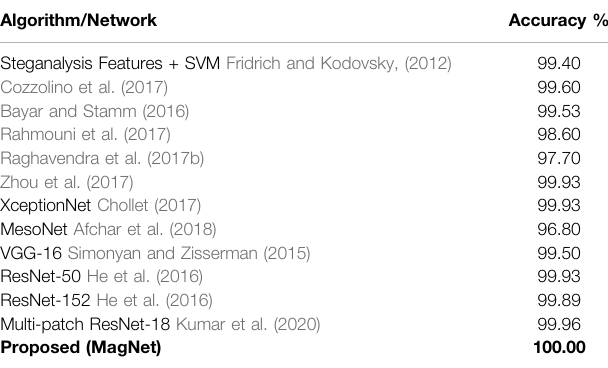
TABLE6| Classi fi cationaccuracyoftheproposedandexistingalgorithmforvideo based morphing attack detection on the FaceForensics database.